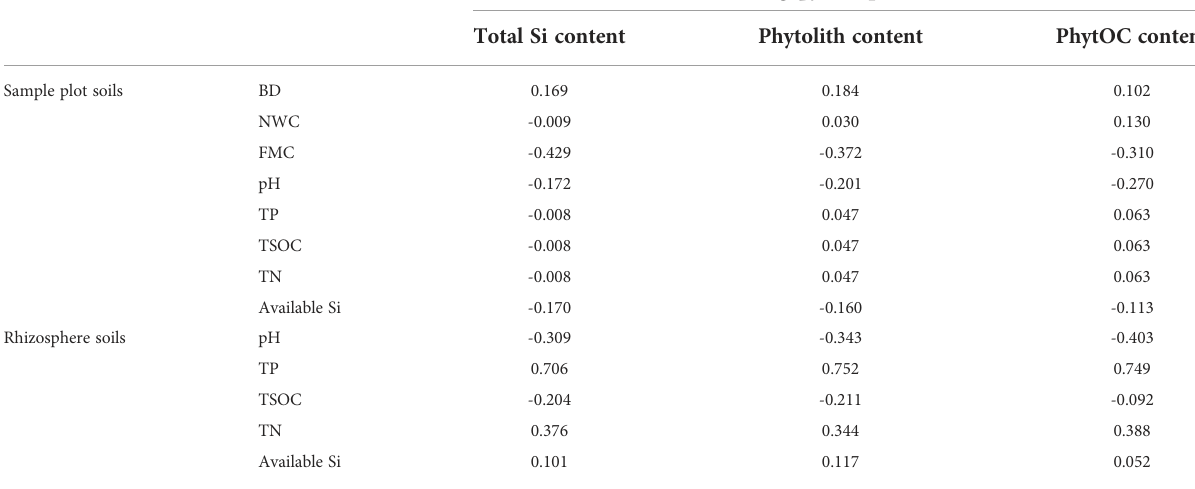
TABLE 4 Correlations between total Si, phytolith, and PhytOC content of plants and physicochemical factors of sample plot and rhizosphere soils. Factors